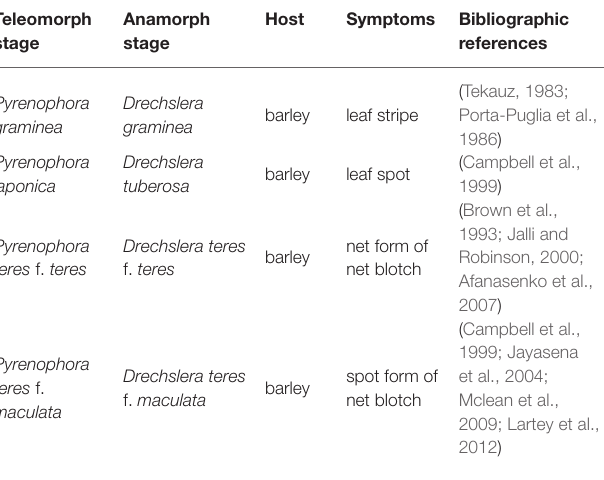
TABLE 1 | Summary of the different species of Pyrenophora , pathogen of